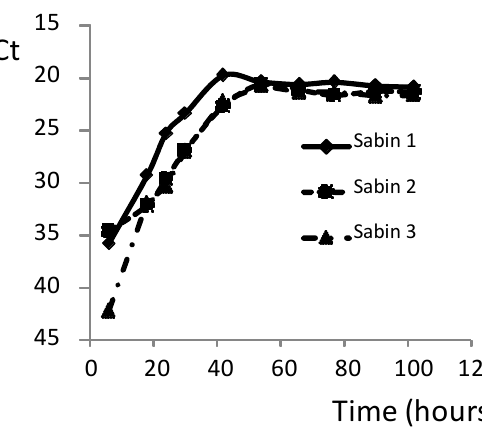
Figure 1. Dynamic growth of the three Sabin strains in HEp-2C cells infected with 100 CCID50 of each of the three Sabin strains simultaneously. Ct: quantitative PCR cycle threshold.